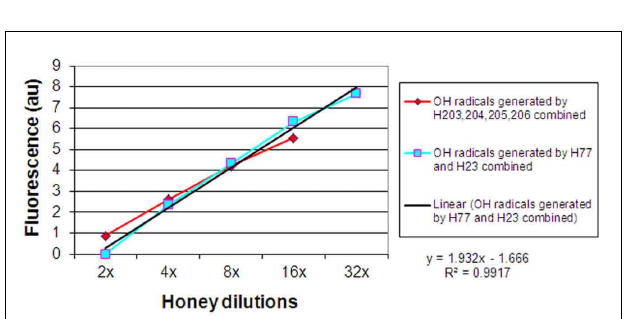
FIGURE 3 | (A,B) Hydroxyl radical generation during incubation of honey with MRSA 6 andVRE 3 cultures. Columns represented mean values ± SEM ( n = 18) of absorbance (turbidity) ofVRE (A) and MRSA (B) cultures (106cfu/well) at each honey dilutions. A line represents mean ± SEM ( n = 18) of hydroxyl radical produced at each honey dilution. Honey represents combined effect of H203, 204, 205, and 206 measured in triplicate.